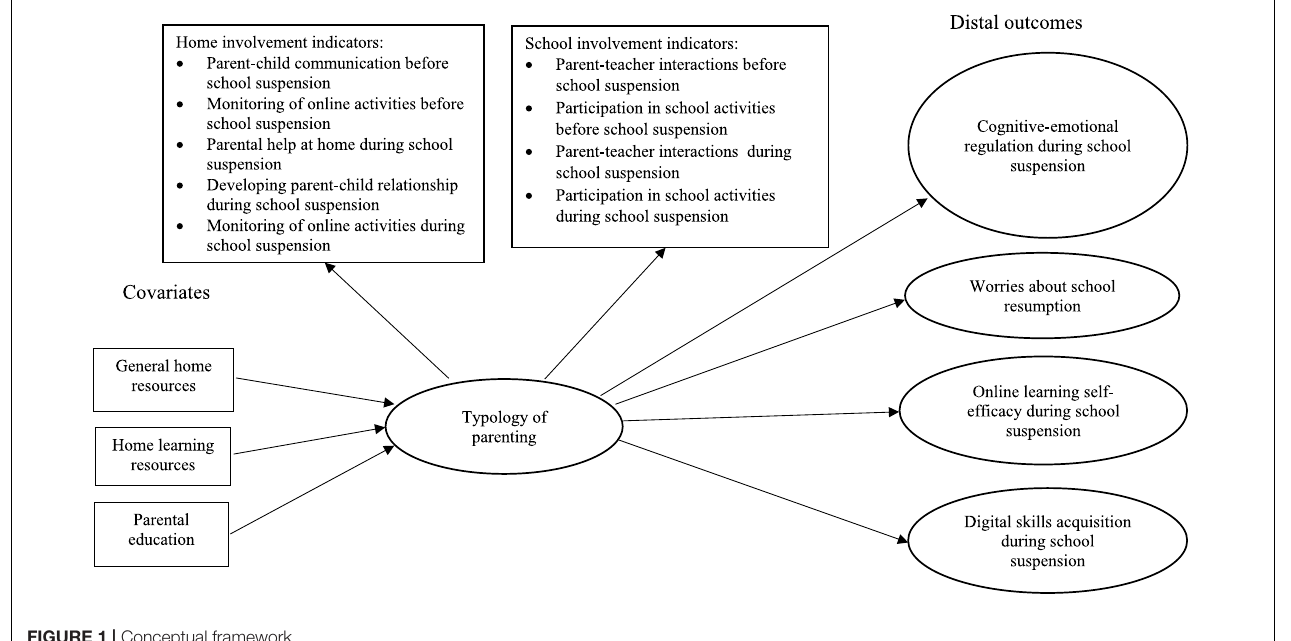
FIGURE 1 | Conceptual